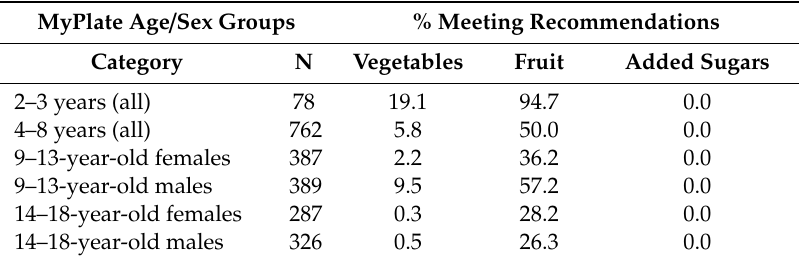
Table 2. Percentage of children meeting MyPlate fruit and vegetable recommendations and the American Heart Association’s (AHA) added sugar